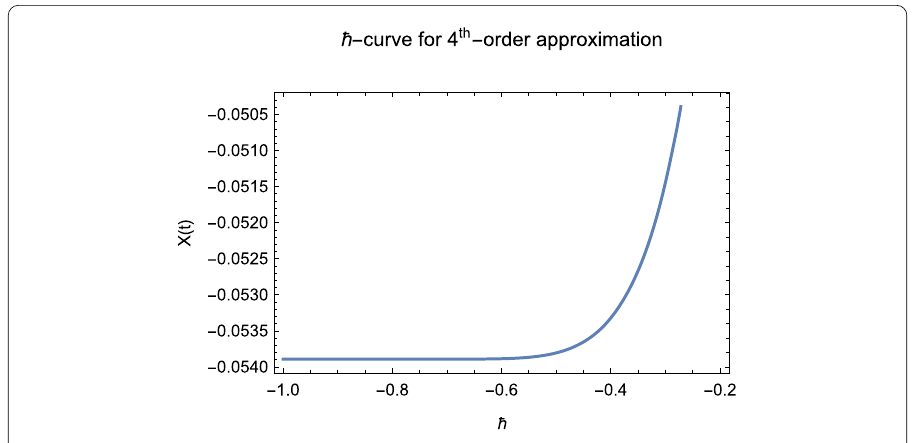
Figure 6 The h -curves of the fourth-order approximations for X ( t )